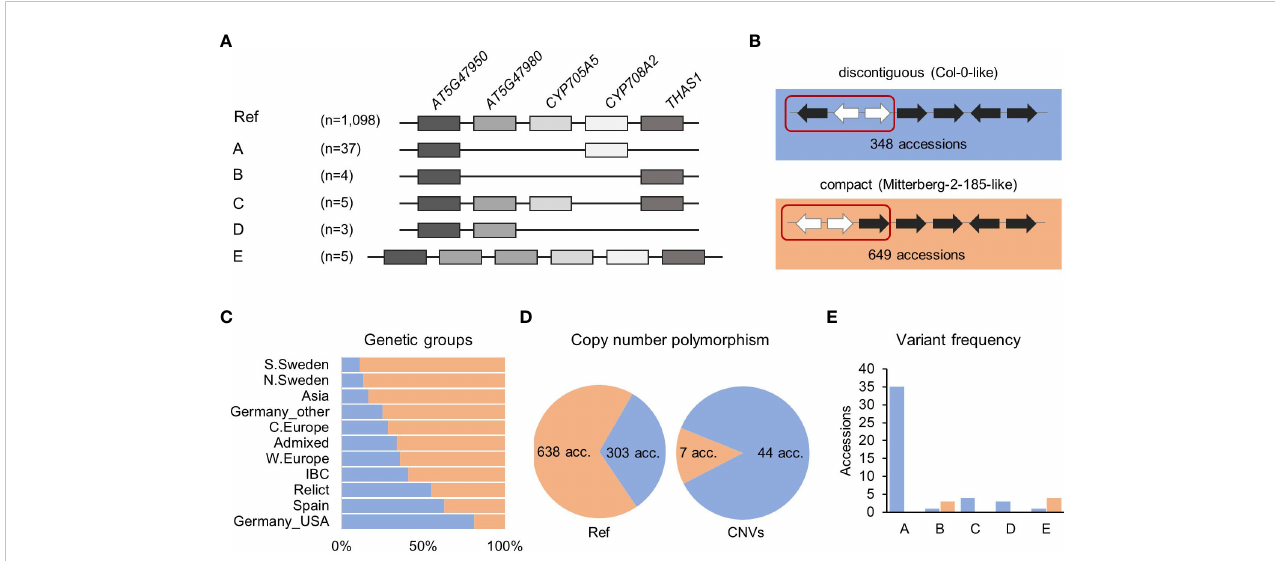
FIGURE 2 Structural variation of thalianol gene cluster. (A) Five types of CNVs that change the number of thalianol cluster genes. The position of intervening genes is ignored and they are not shown. Gene orientation is disregarded. (B) Two versions of thalianol gene cluster organization. Clustered genes are in black; interfering genes are in white. (C) The frequency of the two thalianol gene cluster versions (discontiguous and compact) among the genetic groups. (D) Rate of copy number polymorphism within discontiguous and compact clusters. (E) Frequency of variants presented in (A) among the accessions with different cluster organizations. The number of presented accessions in panels is 1,152 for (A) – genotyping, 997 for (B, C) – inversion detection and 992 for (D, E) – the intersection of the